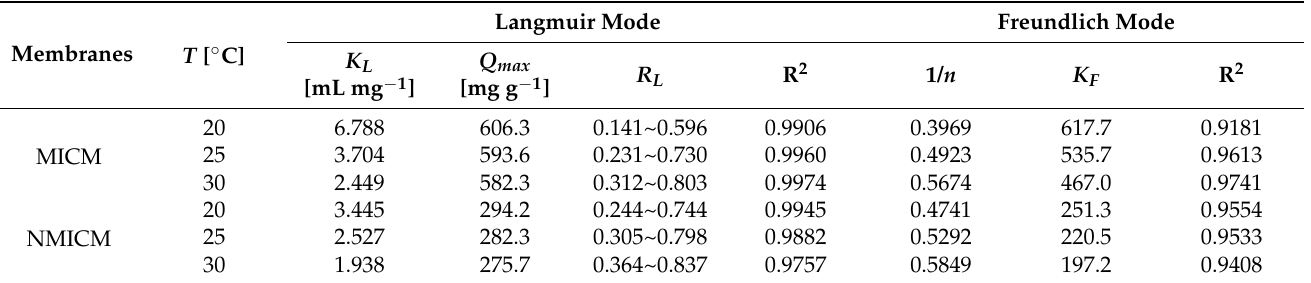
Table 2. Parameters of isotherm at various